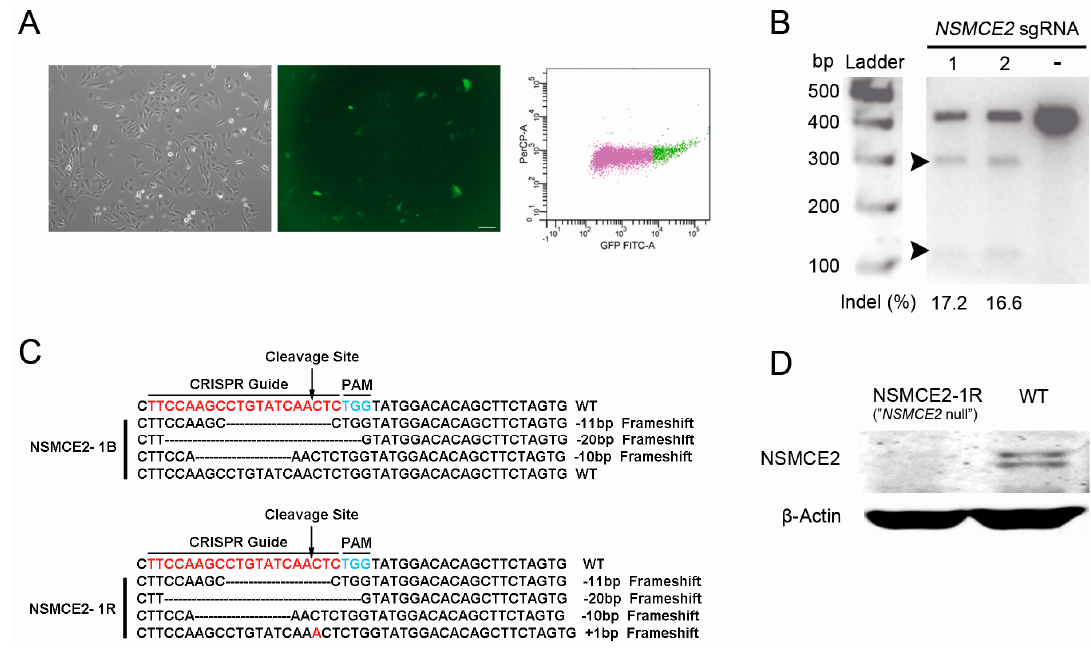
Figure 1. CRISPR-Cas9-mediated targeting of NSMCE2 : ( A ) Left panel, transfected U2OS cells (GFP + ) under bright field and fluorescence; right panel, FACS enrichment of GFP + cells. Bar = 50 µ m; ( B ) Expected cleavage bands (approximately 304 and 113 bp, arrowheads) generated by Surveyor nuclease digestion. For negative control ( − ) transfection of the pX458 plasmids without NSMCE2 sgRNA was performed; ( C ) Sequencing analysis for characterization of the CRISPR-Cas9-induced frameshift mutations. Red letters represent the 20-nt targeting sequences, while blue letters refer to the protospacer-adjacent motif (PAM); ( D ) Western blot analysis of the NSMCE2 protein in the final NSMCE2 null and WT cells. β -Actin was used as a loading control.